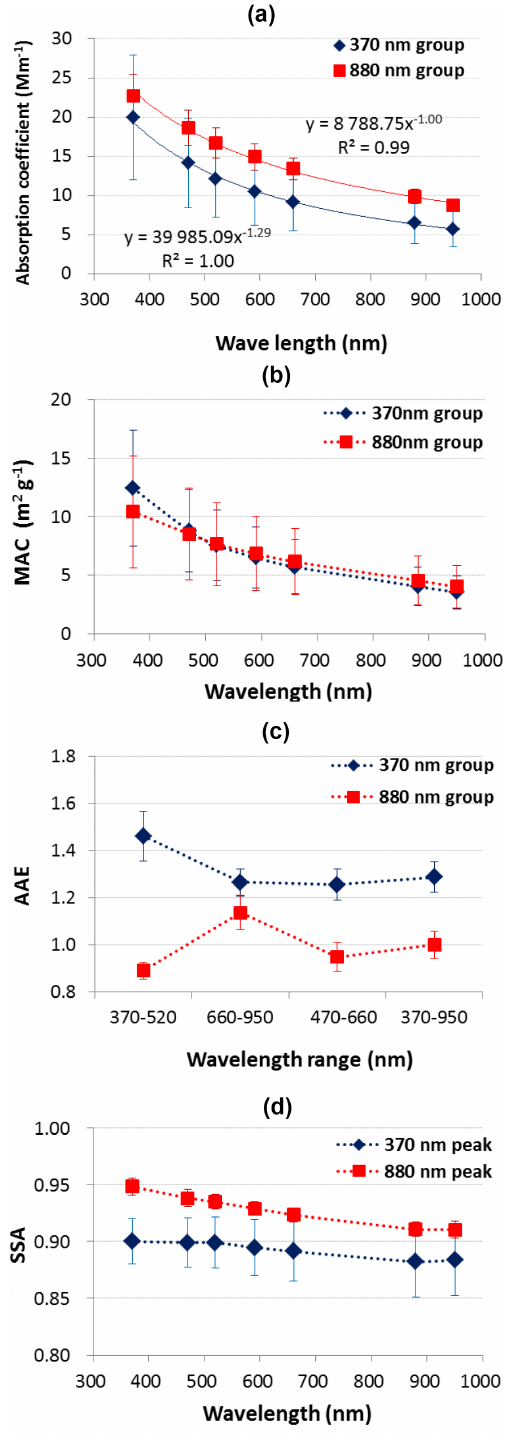
Figure 5. (a) Absorption coefficients ( σ ap ) of the 370 and 880nm groups and fitted absorption ångström exponent (AAE). (b) Mass absorption cross section (MAC) of the two groups (Please see text for details of the calculation). (c) AAE for the two groups in differ- ent wavelength ranges. (d) Single scattering albedo (SSA) along the wavelengths for the two